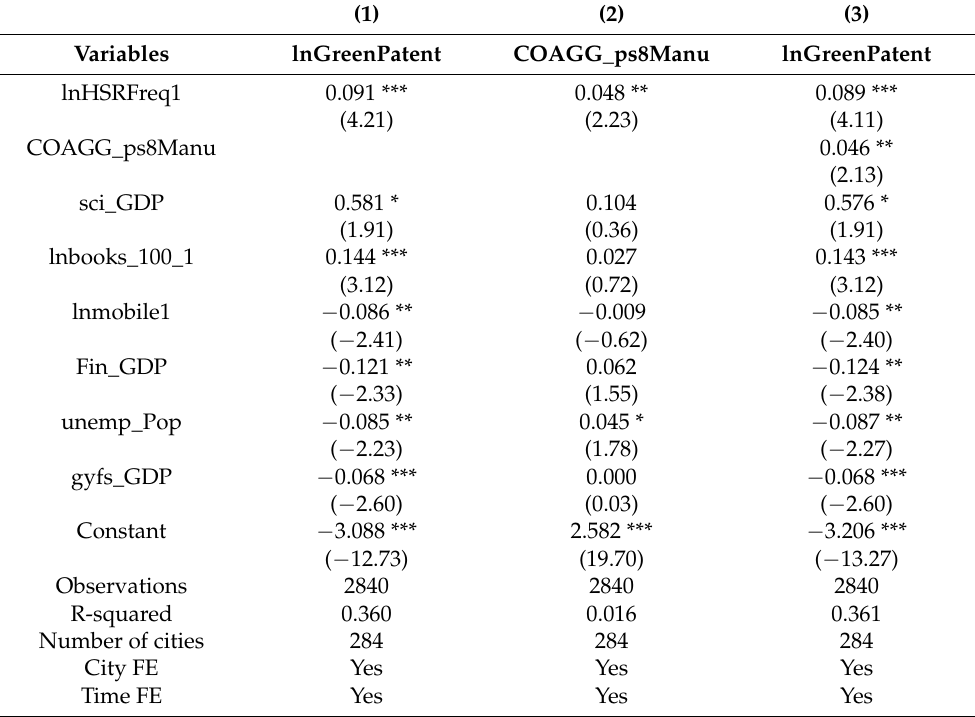
Table 4. The empirical results of the mediating effect